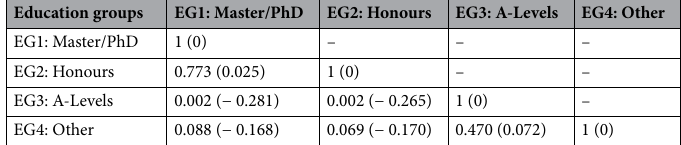
2 (in bracket) based on paired Wilcoxon tests for TLX scores four education